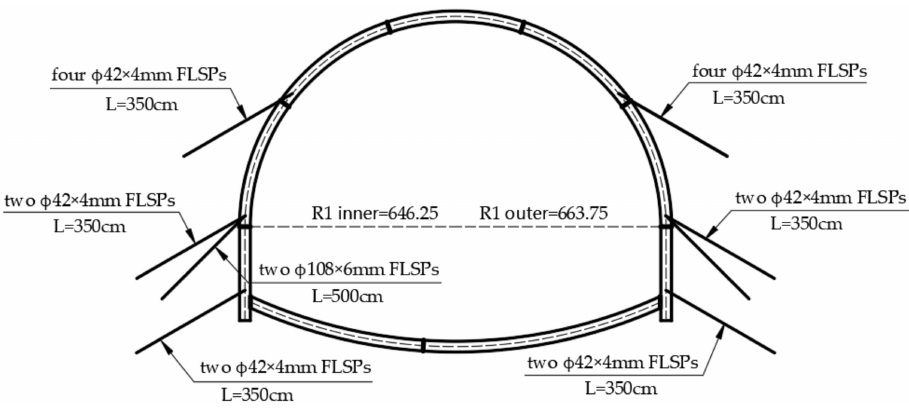
Figure 9. Design drawing of